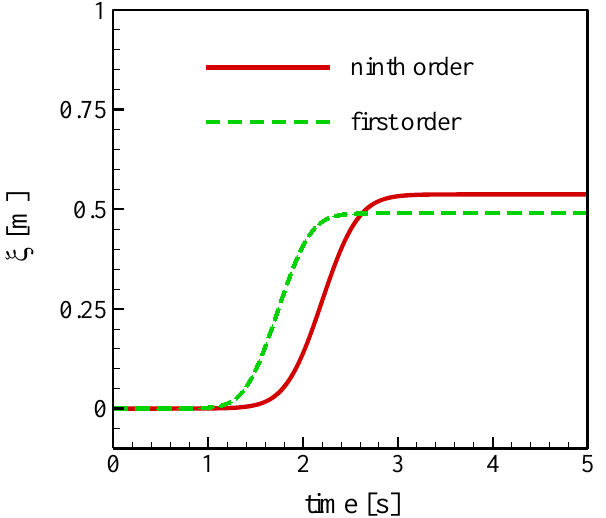
Figure 2. Time histories of paddle displacement based on both the first-order and ninth-order solutions of solitary waves.